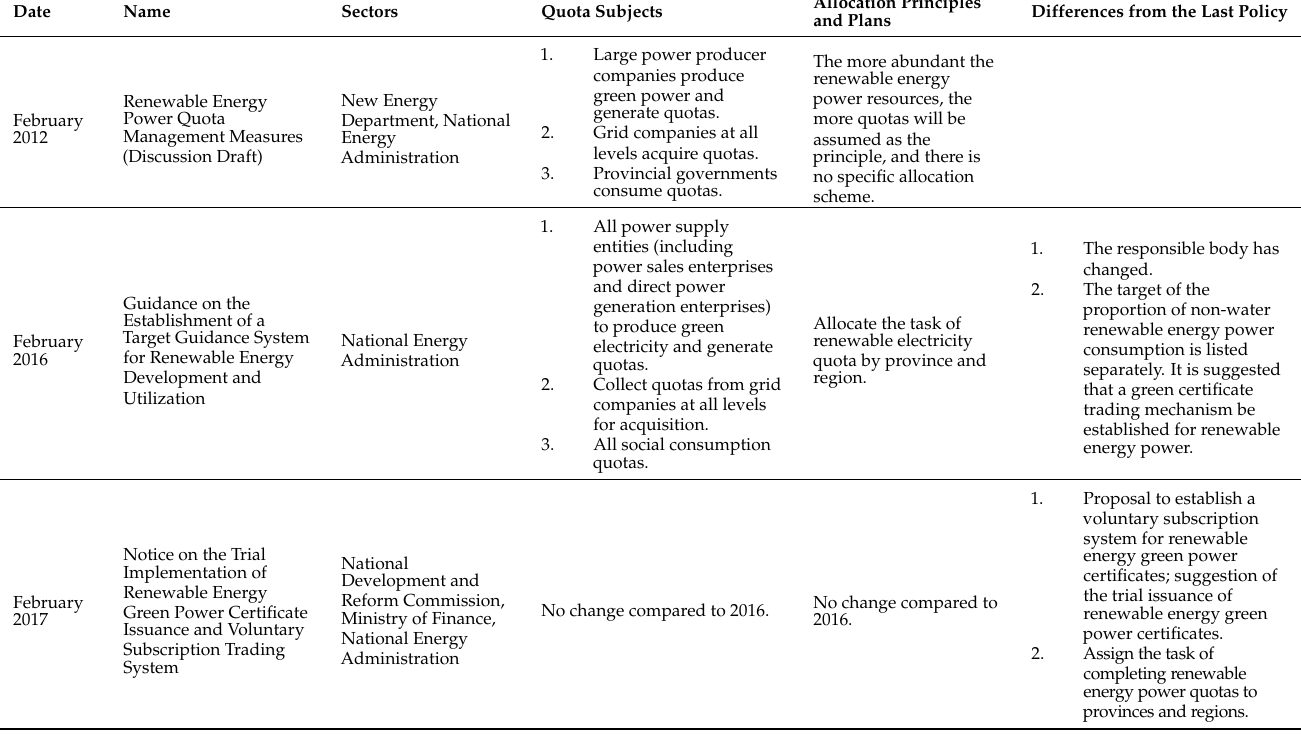
Table 1. Typical documents and differences in the process of renewable energy policy formulation.